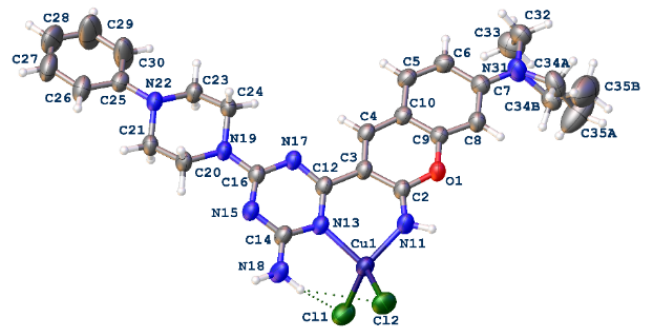
Figure 4. The dimeric molecular structure of 2f . Displacement ellipsoids are shown at the 50% probability level.